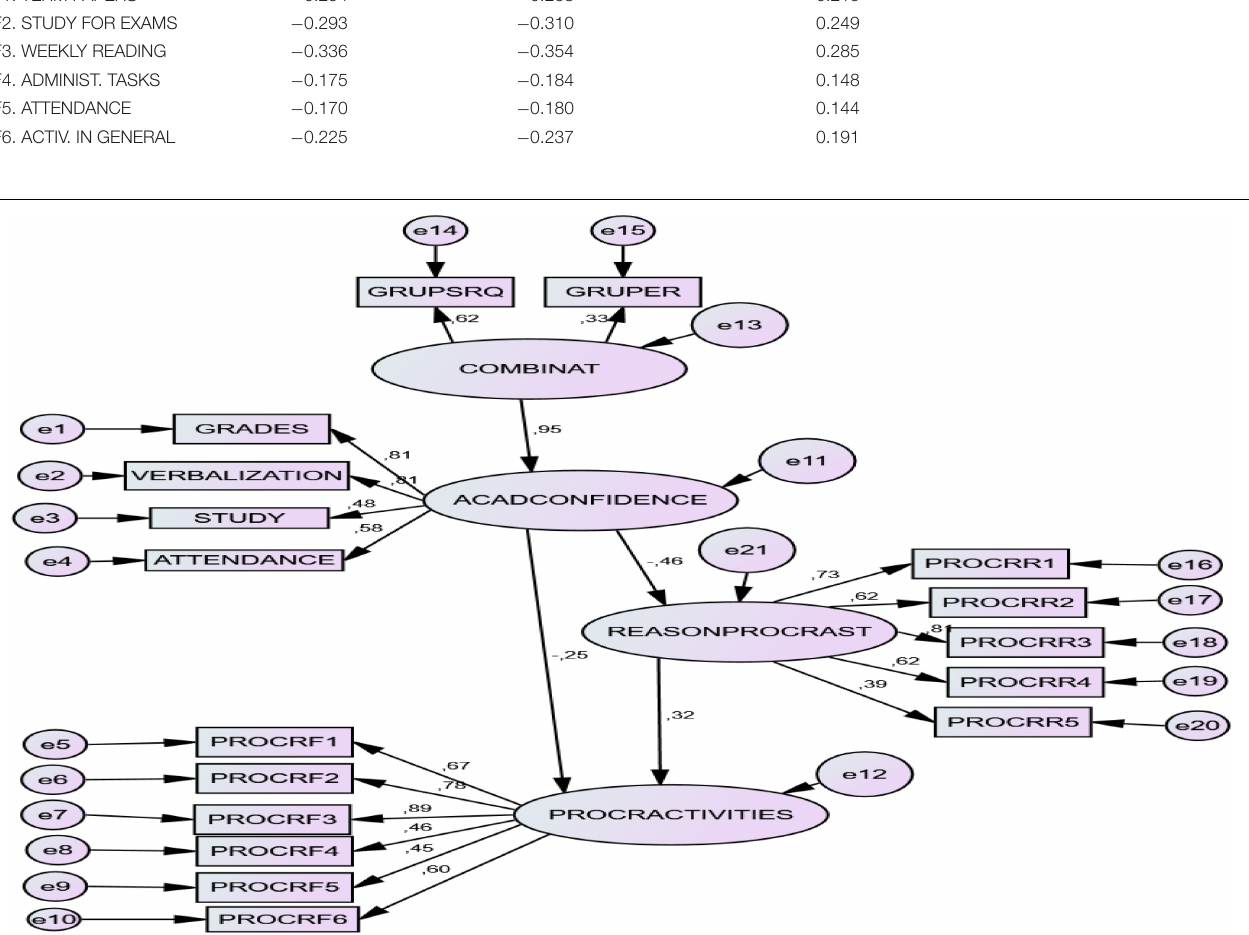
FIGURE 5 | SEM of relations between academic behavioral confidence, reasons for procrastination and procrastination activities. COMBINAT, SR and RT GROUPS : ACADCONFIDENCE, Academic Behavioral Confidence ; REASONPROCRAT, Reasons to procrastinate : RR1. AROUSAL SEEKING; RR2. LOW CONTROL; RR3. PERFECTIONISM; RR4. TEST ANXIETY; RR5. LOW CONFIDENCE. PROCRACTIVITIES, Procrastination activities (Factors): F1. TERM PAPERS; F2. STUDY FOR EXAMS; F3. WEEKLY READING; F4. ADMINIST. TASKS; F5. ATTENDANCE; F6. ACTIV. IN